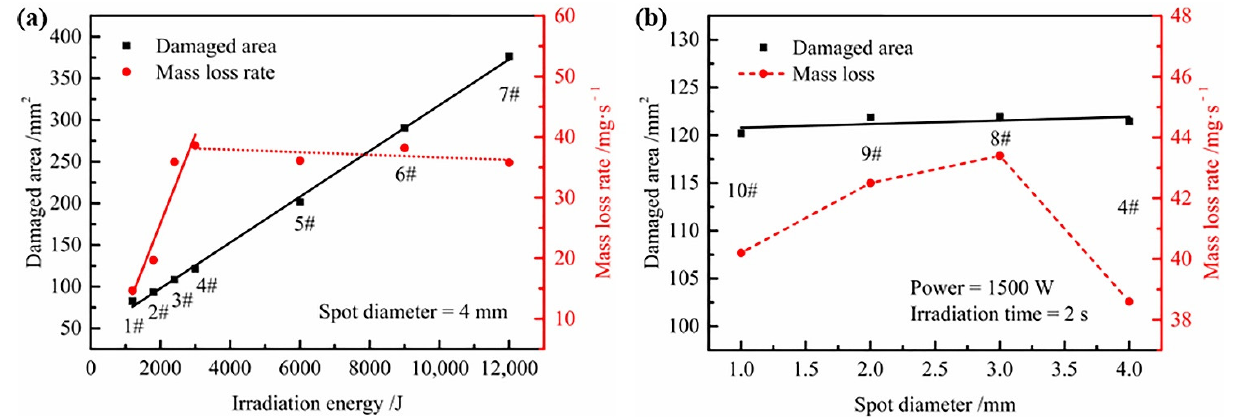
Figure 3. ( a ) Influence of laser energy on damaged area and mass loss rate of CF/PAEK, with the same spot diameter (4 mm); ( b ) influence of the spot diameter on damaged area and mass loss rate of CF/PAEK, with the same laser energy (3000 J).